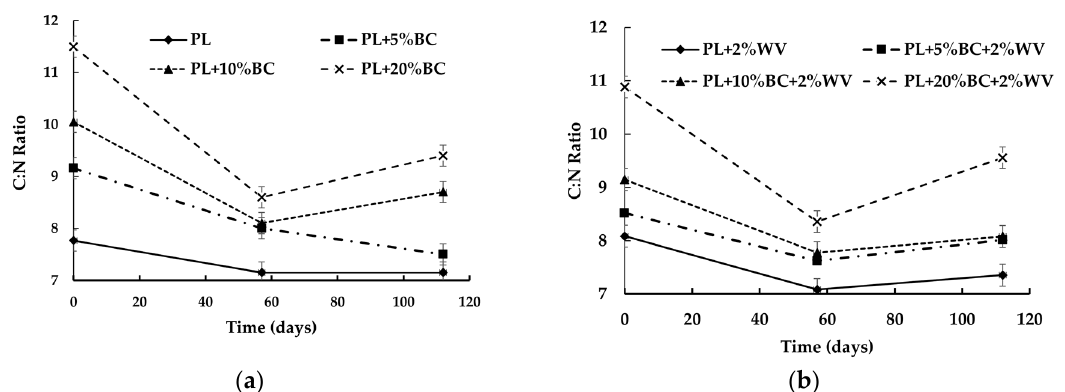
Figure 3. C:N ratios for treatments without WV ( a ) and with WV ( b ) over time.